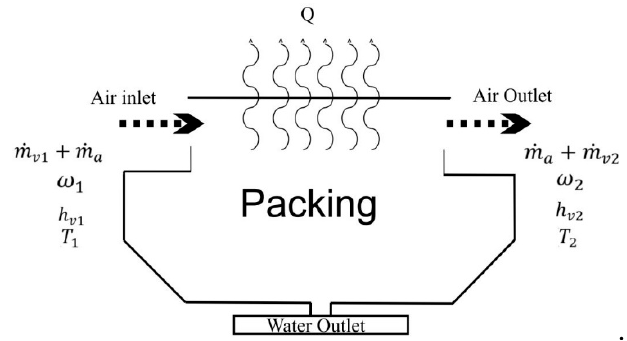
Figure 7. Schematic of physical model for the air dehumidification (AWG).